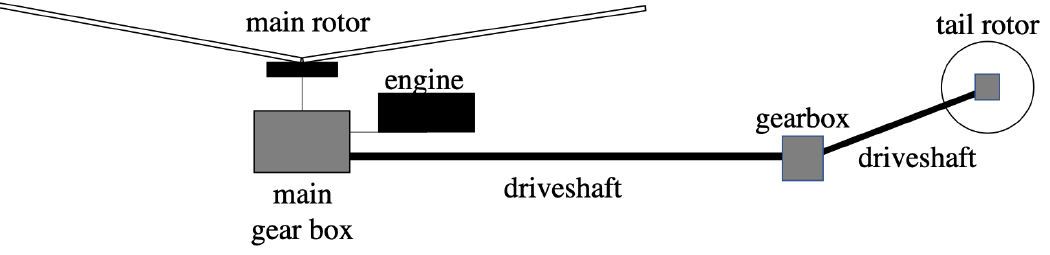
Figure 11. Notional representation of the helicopter drive train in conventionally powered